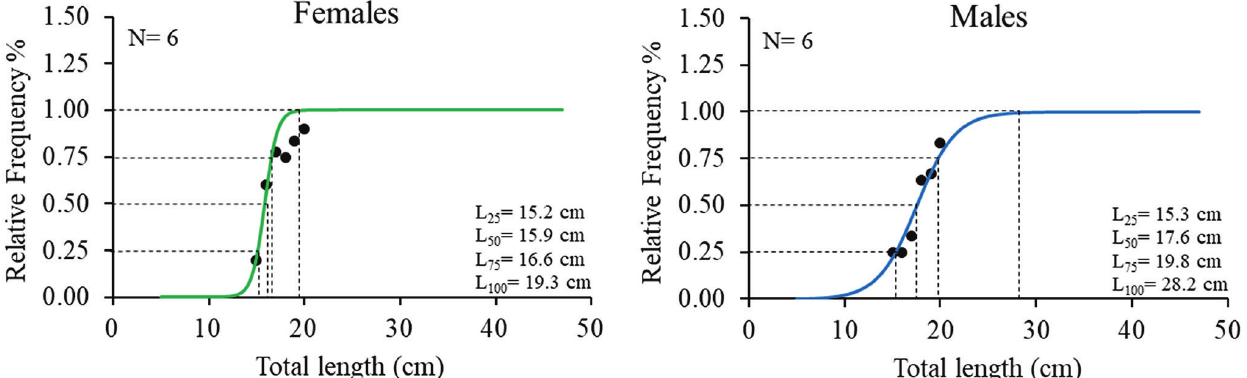
Fig. 6. Lengths of sexual maturation for males and females of Genidens genidens in Guanabara Bay, Rio de Janeiro, Brazil. Points are the observed values and the continuous line the calculated values.